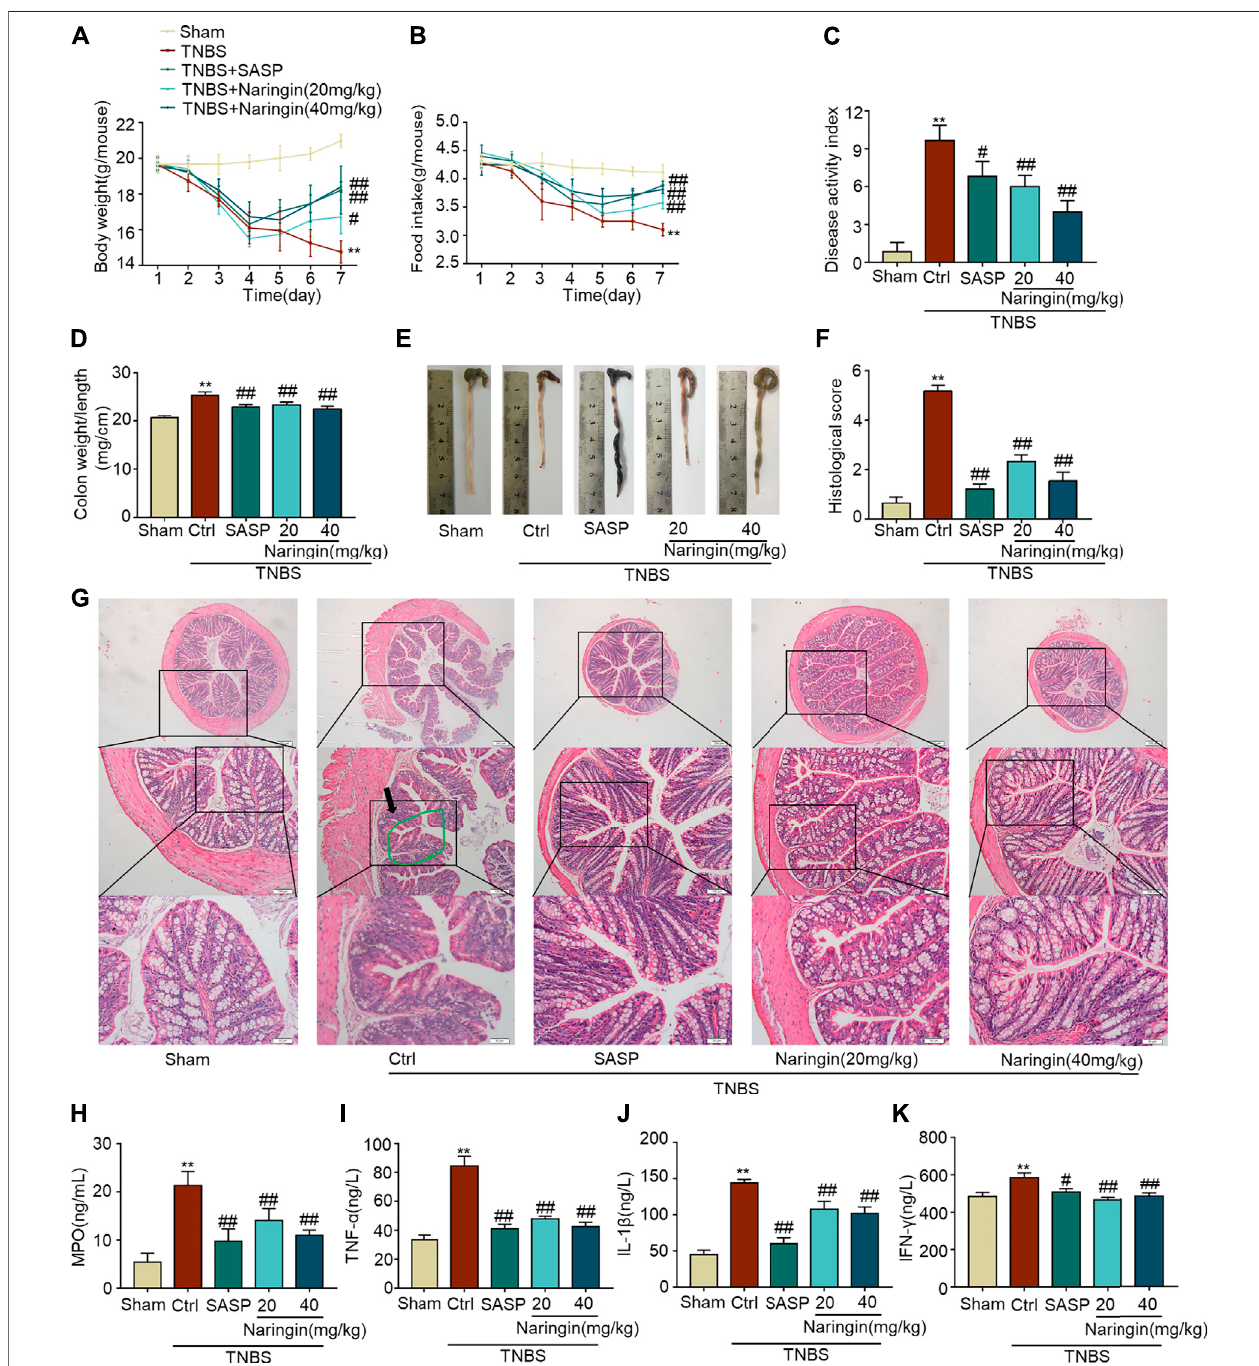
FIGURE 10 | Effects of naringin on TNBS-colitis. Naringin was administered to mice by gavage once a day for seven consecutive days. Effects of naringin on (A) bodyweight, (B) foodintake, (C) DAI, (D) colonweight-to-lengthratio,and (E) grossmorphologyofcolontissue. (F) Totalhistologicalscorewascalculatedasthesumof epithelialdamageandhistologicalscore. (G) HandEstainingofmicecolonictissue.Scalebars,200,100,and50 μ m.Greenringindicatesdamagedvillistructure;black arrow indicates in fi ltration of in fl ammatory cells. Expression levels of the colonic cytokines (H) MPO, (I) TNF- α , (J) IL-1 β , and (K) IFN- γ were determined by ELISA. Data are expressed as mean ± SD. Values in the sham group are set to 100% and other values are given relative to those in the sham group. ** p < 0.01 compared with sham group; # p < 0.05, ## p < 0.01 compared with TNBS-colitis group; n (cid:2) 6 samples.